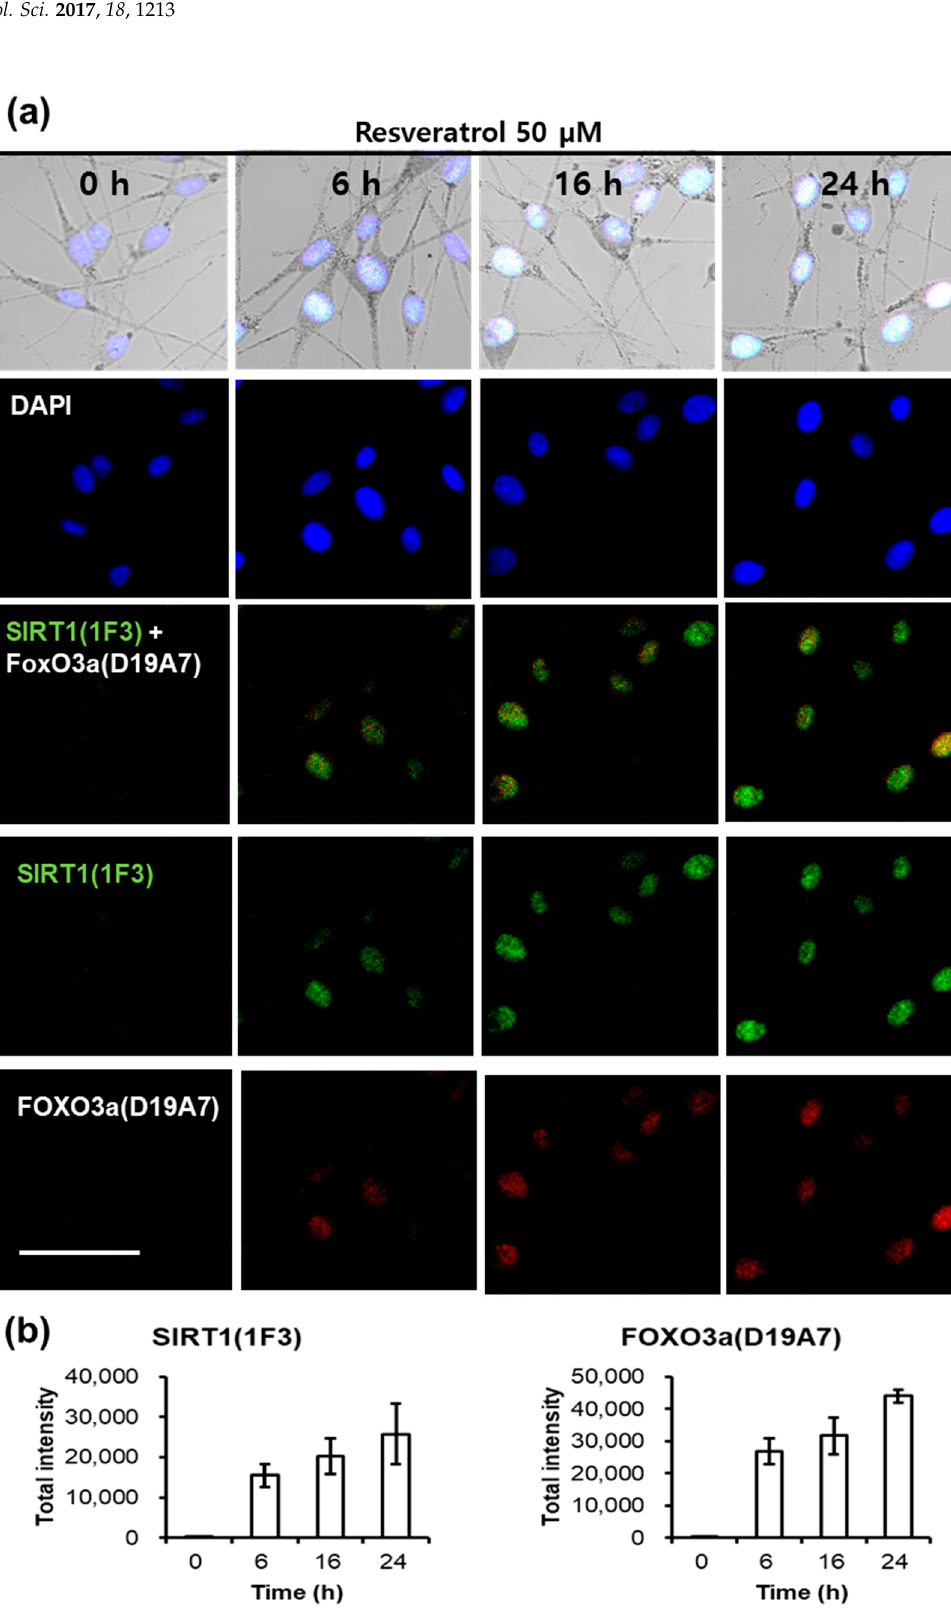
Figure 7. Fluorescent microscopic observation of SIRT1, FOXO3a in resveratrol-treated normal human melanocytes. ( a ) After resveratrol treatment, cells were stained at different time points (0, 6, 16, and 24 h); ( b ) Staining intensity of SIRT1 and FOXO3a after resveratrol treatment at different time points (0, 6, 16, and 24 h). Scale bar = 50 μ m